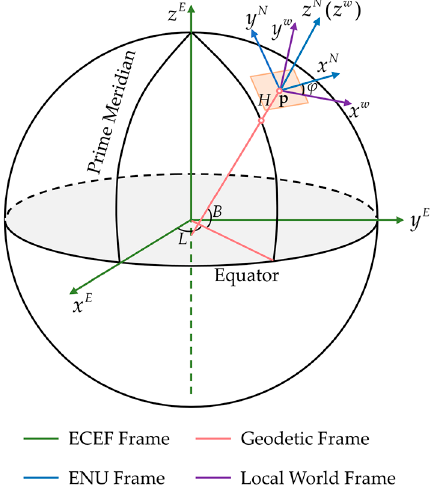
and q b c c . t r represent the p c δ t rep- δ t and  r r